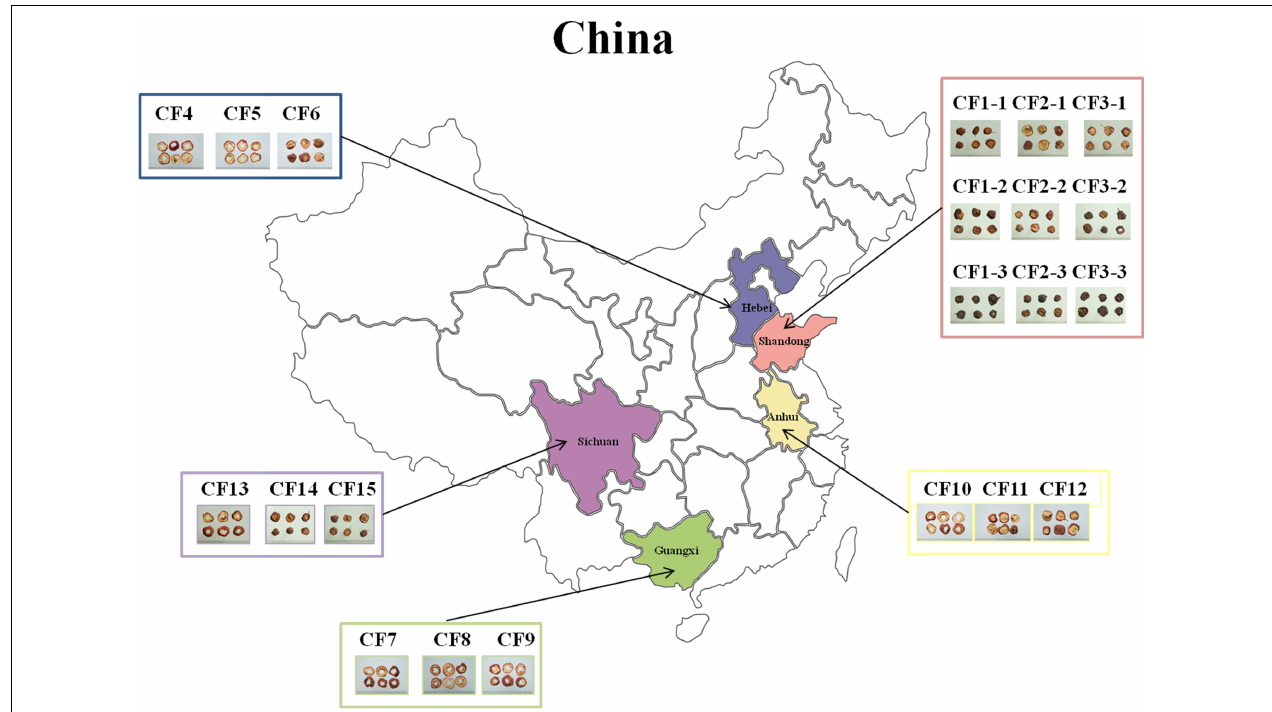
FIGURE 1 | Overview of sampling in this study. A total of 21 Crataegi Fructus (CF) samples were collected from five provinces in China: Shandong ( n = 9), Hebei ( n = 3), Anhui ( n = 3), Guangxi ( n = 3), and Sichuan ( n = 3) provinces. TABLE 1 | Information for the Crataegi Fructus samples in this study. Voucher